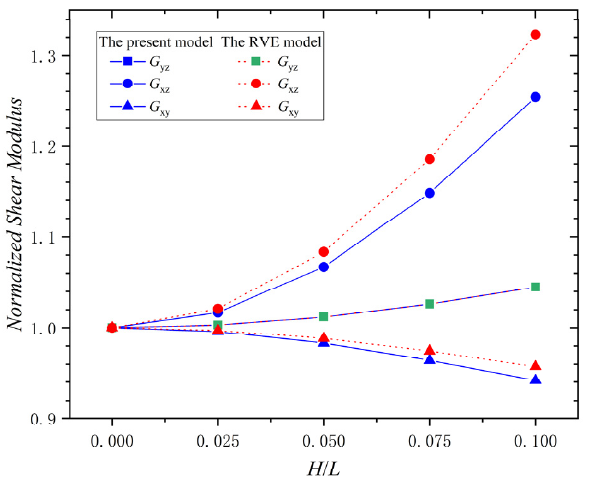
tion of the laminate. Figure 7. Normalized Young’s modulus vs. wrinkle parameter H/L and ϕ = 0 ◦ . Figure 7. Normalized Young’s modulus vs. wrinkle parameter 𝐻 / 𝐿 and 𝜑 = 0°. The relationship between the shear modulus ( 𝐺 (cid:2935)(cid:2936) , 𝐺 (cid:2934)(cid:2936) , 𝐺 (cid:2934)(cid:2935) ) and 𝐻/𝐿 of the ply with a wrinkle at 𝜑 = 0° is shown in Figure 8. The normalized shear modulus 𝐺 (cid:2935)(cid:2936) in the present